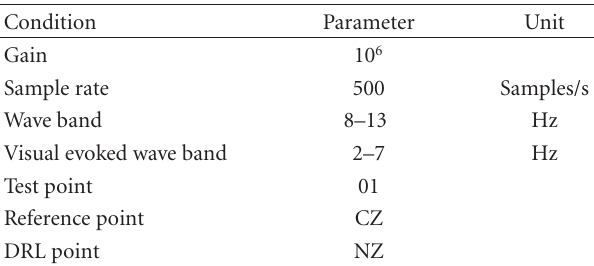
Table 2: Measurement parameters.